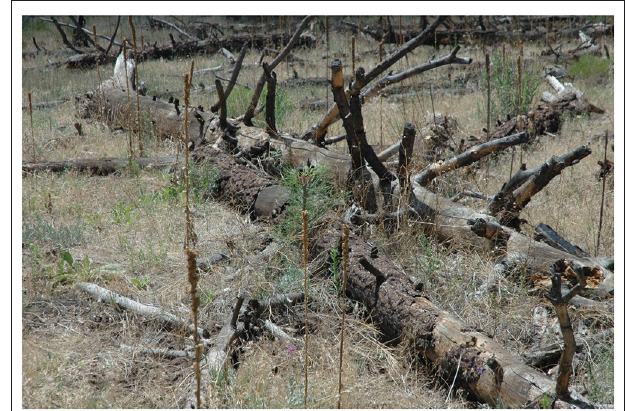
FIGURE 1 | Climate related changes in Southwest forests. Southwestern ponderosa pine (Pinus ponderosa) forests provide an example of the irreversible ecological changes occurring and the interface between these changes and societal expectations. These forests, already stressed by a multi-year drought, are increasingly at risk of uncharacteristic crown fires. Longer, hotter, and dryer summers in recent decades have led to the largest recorded fires in Arizona and New Mexico. Several recent fires have created large (tens to 100’s of hectares) patches of high severity fire where 100% of the trees are killed. Following these severe fires, droughty conditions and lack of seed source may preclude ponderosa pine regeneration, especially on some soil types ( Puhlick et al., 2012). These post-fire patches may become grassy meadows with low densities of pine seedlings, well below numbers thought to have occurred historically ( Owen et al., 2017). Patches of disturbance-adapted non-native species, some of which are highly invasive may become established, replacing native understory plant species ( Sabo et al., 2009 ). Alternatively, more productive areas may develop into dense shrub fields (Savage and Mast, 2005). Evidence increasingly suggests that the combination of high severity fire and subsequent drought can lead to pine regeneration failures (Savage et al., 2013). Public land managers, driven by societal desires to see pine forests return as well as laws and regulations requiring replanting, feel pressure to replant pine seedlings in burned areas. Yet, the reality is that even repeated replanting may fail to restore pine forests in some areas. Replanting success can be increased to some degree by choosing sites where seedlings are more likely to survive, and data from scientific studies and monitoring, as well as modeling can help guide these efforts. However, in some locations and especially after multiple wildfires, the odds of pine seedlings regenerating and surviving are small (e.g., Guiterman et al., 2018 ) leading to transitions to shrub or grass dominated communities. Acceptance of this type of ecosystem transition may be difficult to accept and only through discussions and monitoring activities can diverse stakeholders become more in tuned to these